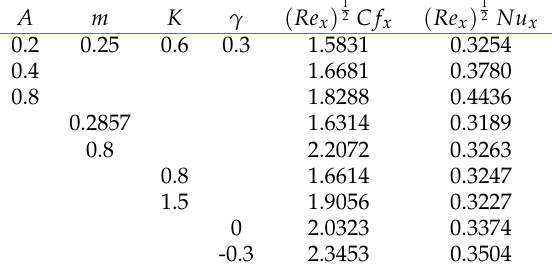
Table 3. Numerical results of skin friction coefficient and Nusselt number for various values of A, m, K and γ . Table 3 represent the influences of governing parameters on the variation of skin friction coefficient and Nusselt number. It is observed that the skin friction